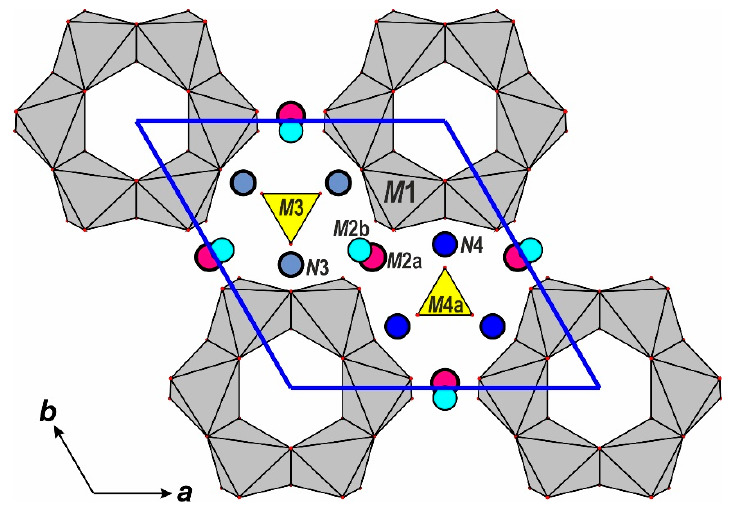
Figure 3. The arrangement of the cations over M (2), M (3), and M (4) sites in the crystal structure of the Mn-deficient analogue of manganoeudialyte.